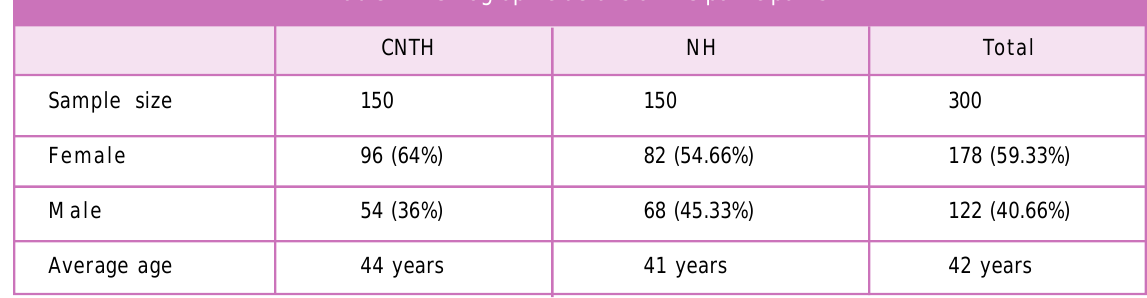
Table 1. Demographic details of the